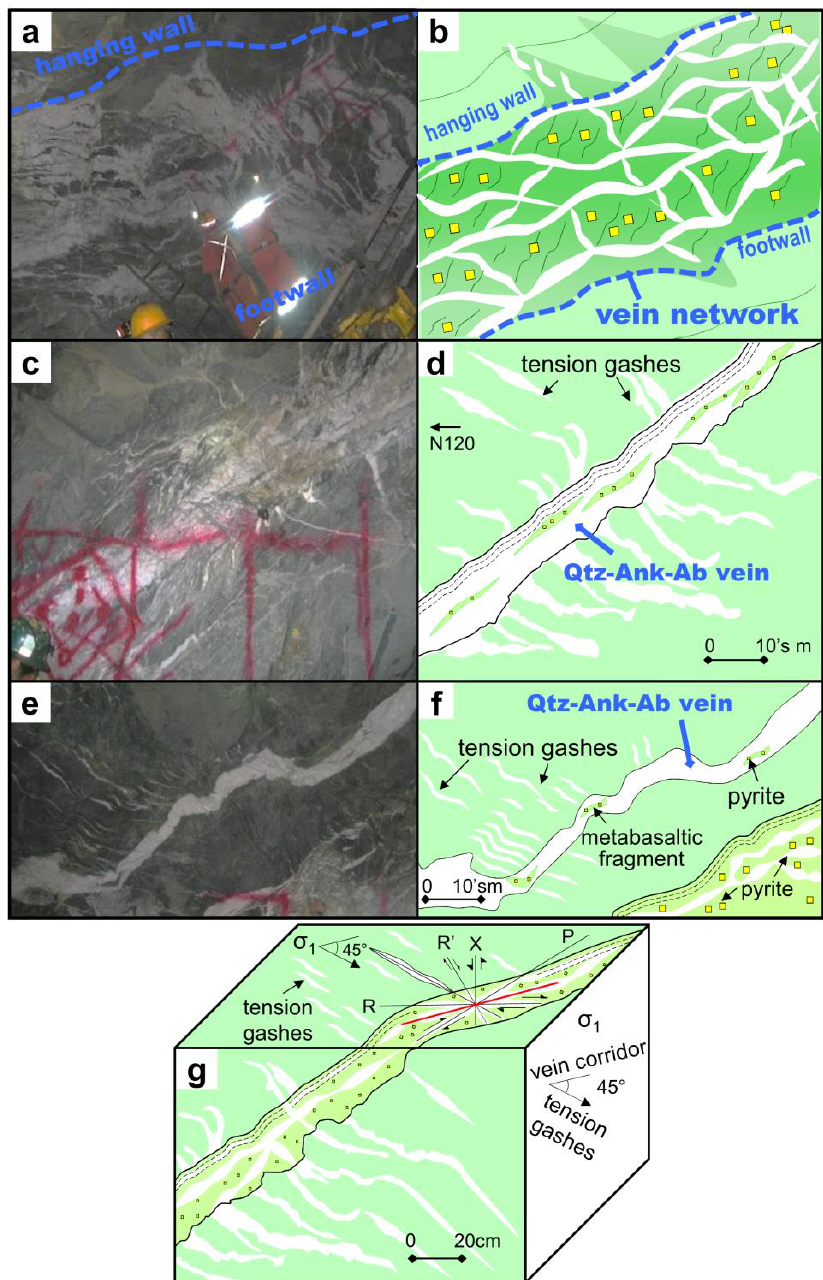
Figure 11. ( a – f ) Photographs from underground workings ( a , c , e ) and corresponding schematic drawings ( b , d , f ) illustrating sequential steps in the formation of the El Callao vein system, from early ( e , f ) to late ( a , b ) stages. ( a , b ) Example of quartz–ankerite–albite vein network englobing rich-pyrite metabasaltic fragments, illustrating the mature vein system. ( c , d ) Photograph showing the quartz–ankerite–albite veins, incorporating slivers of detached pyrite-rich metabasaltic fragments, parallel to contacts. ( e , f ) A satellite vein of the interconnected network associated to extensional tension gashes, illustrating early stages of vein network formation. ( g ) A block diagram illustrating the structural setting of the shear zone and associated network of veins and tension gashes, as well as the metabasaltic fragments containing gold-bearing pyrite. The red line on the top indicates the orientation of shear ( c ) plane.